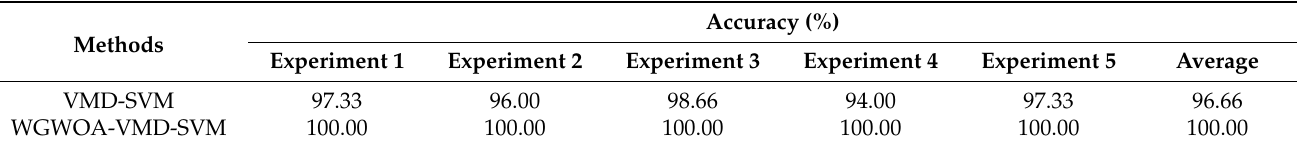
Table 3. Diagnostic accuracy of different methods.